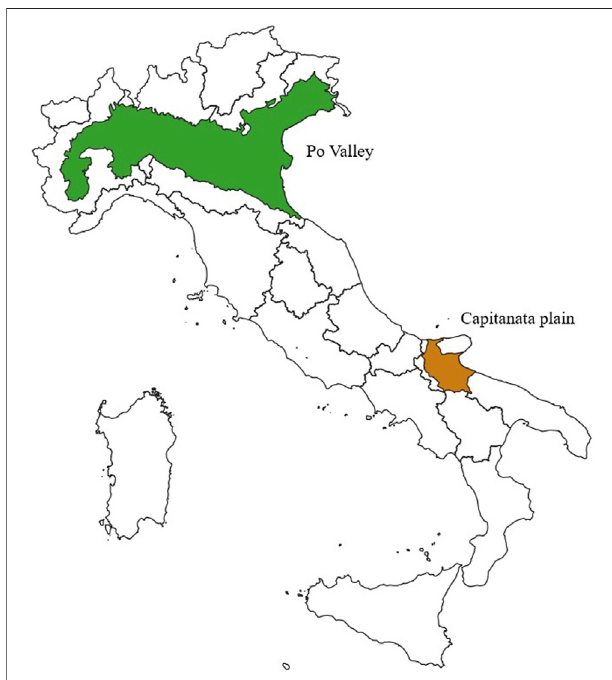
FIGURE1| Selected casestudy areas: PoValley in NorthernItaly (green colour) and Capitanata Plain in Southern Italy (orange colour).